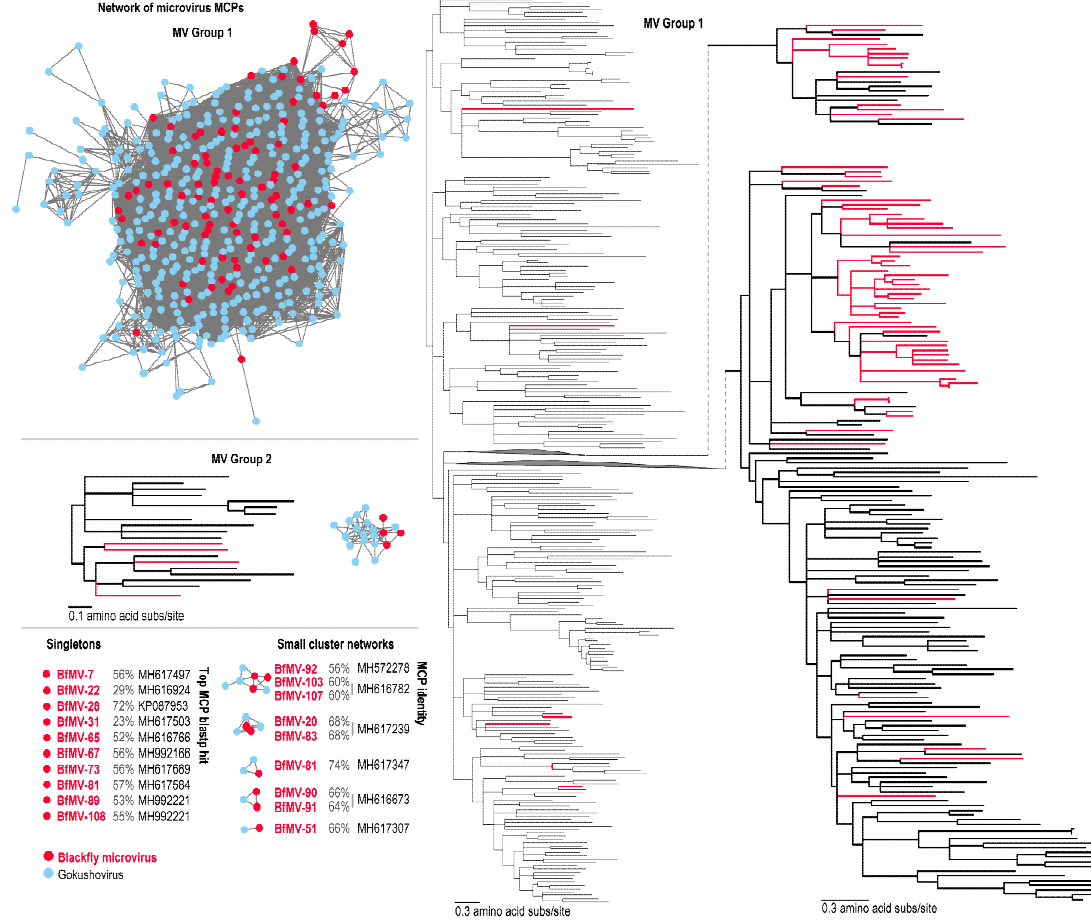
Figure 4. Network analyses of the microvirus major capsid protein. Maximum likelihood phylogeny of the MCP sequences of microviruses for the two major groups (MV group 1 and 2) are shown. Smaller networks and singletons are shown with closet Rep comparisons and percentage similarities. Blackfly derived sequence are shown in red.